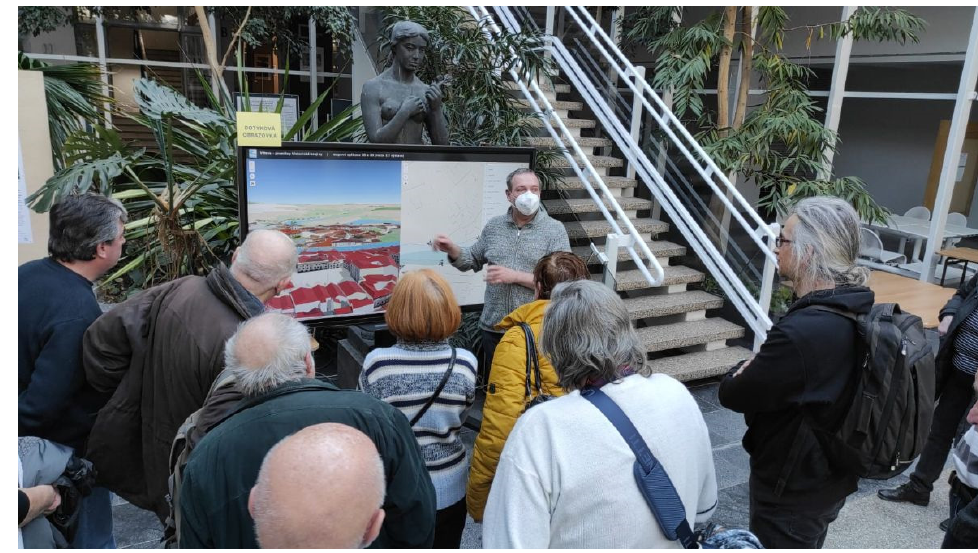
Figure 16. Demonstration of a 3D web application created by a member of the Vltava Project.